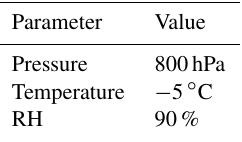
Table 2. Initial conditions for parcel model simulations.